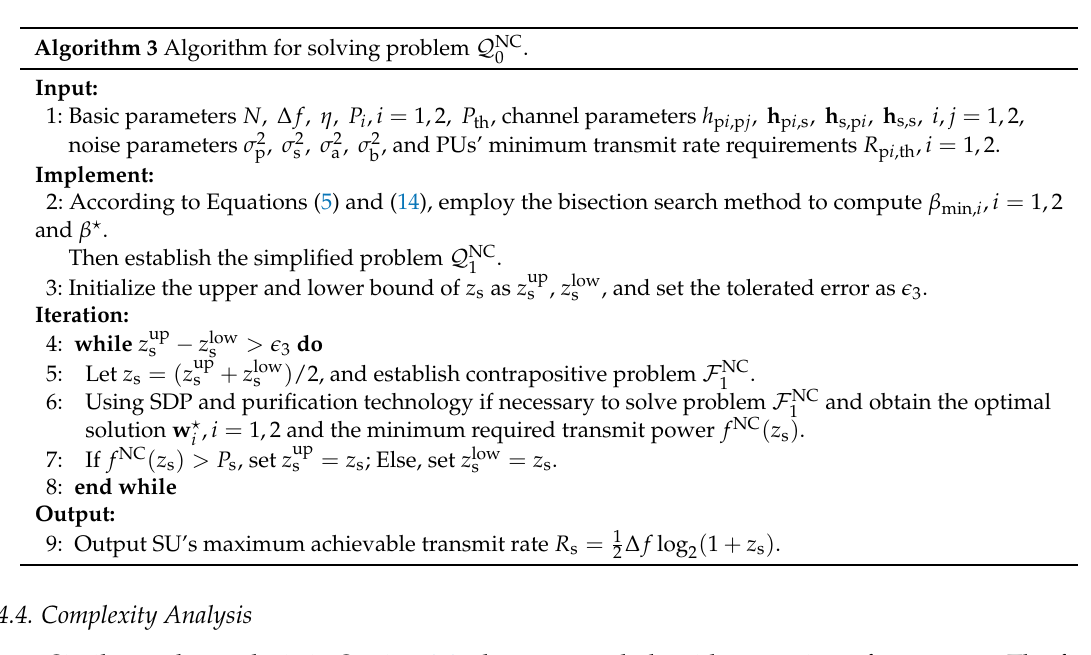
Algorithm 3 Algorithm for solving problem Q NC